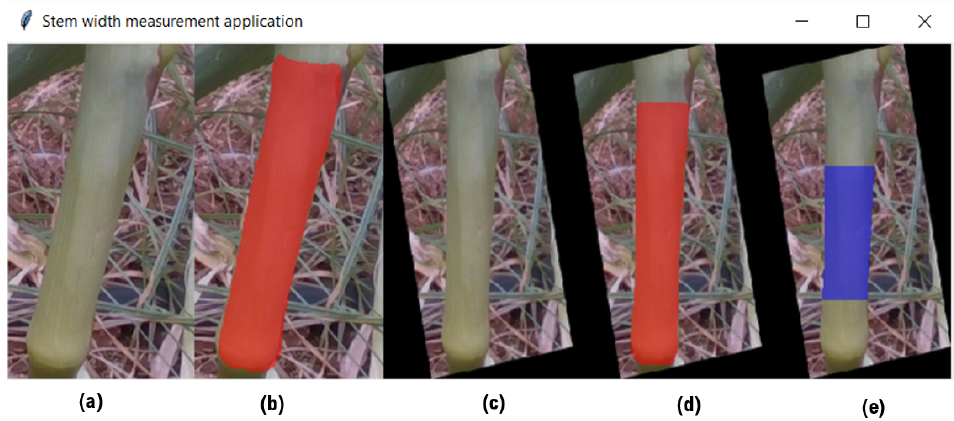
Figure 13. Visualization of stem width estimation process of the application. Red color mask indicates the segmentation result, and blue mask indicates the measured width lines. ( a ) We crop each of the detected stems from the RGB and depth images based on the identified bounding box coordinates. ( b ) We run the mask R-CNN model on the cropped RGB images of the detected stem. The segmentation for each stem is then used for estimating the orientation of the stem, used for canonization of the stems. The orientation estimation is done by finding the incline of the line between the highest and the lowest pixels that belong to the stem. ( c ) We rotate the cropped RGB and depth images according to the orientation angle in order to bring the stem into a vertical position. ( d ) We run the mask R-CNN again on the canonized RGB image of the stem in order to find the segmentation of the vertical stem. ( e ) We identify pixels in the mid-section of the stem, to be used for width estimation. The selected pixels are the leftmost pixels in the middle area of the segmentation and their corresponding rightmost pixels over the same horizontal lines. The algorithm ignores horizontal lines that their lengths are 3 standard deviations away from the average length of all the lines. The average distance, computed as in the ball diameter estimation above, of all unfiltered lines is reported as the stem width.